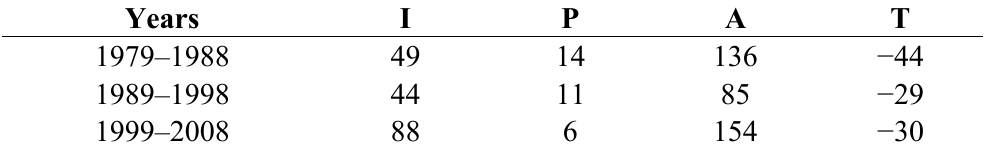
emissions and driving forces in China (growth in Table 1. CO 2